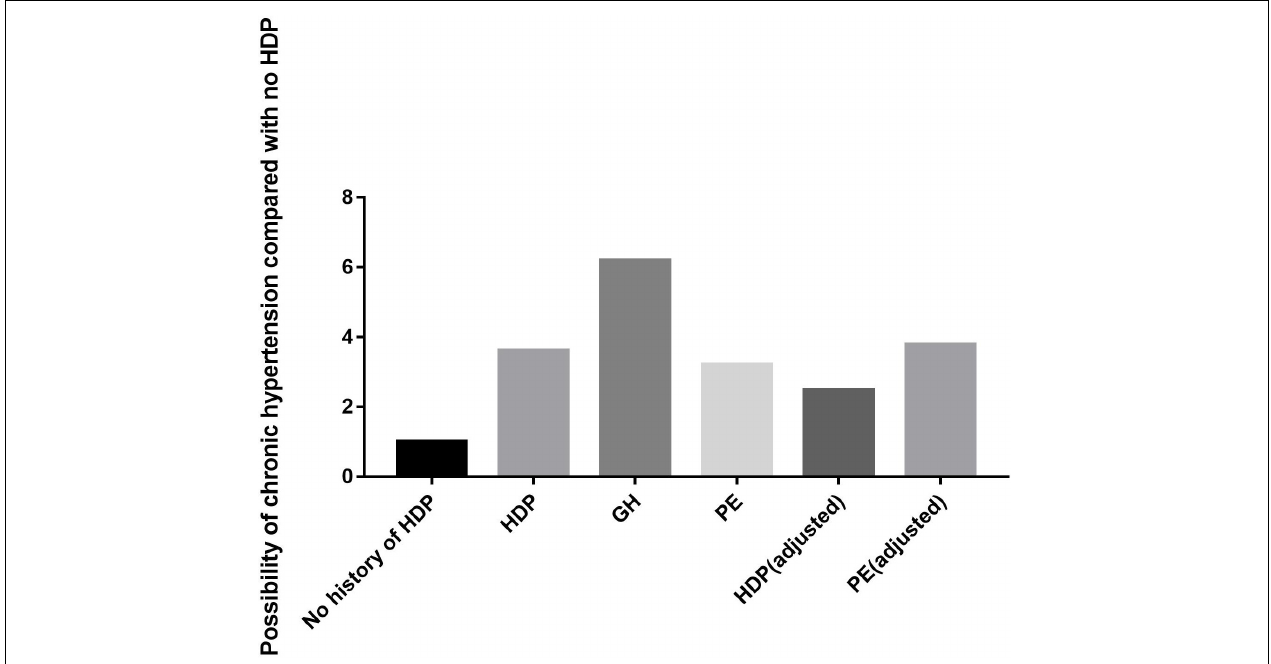
FIGURE 12 | Main findings of the